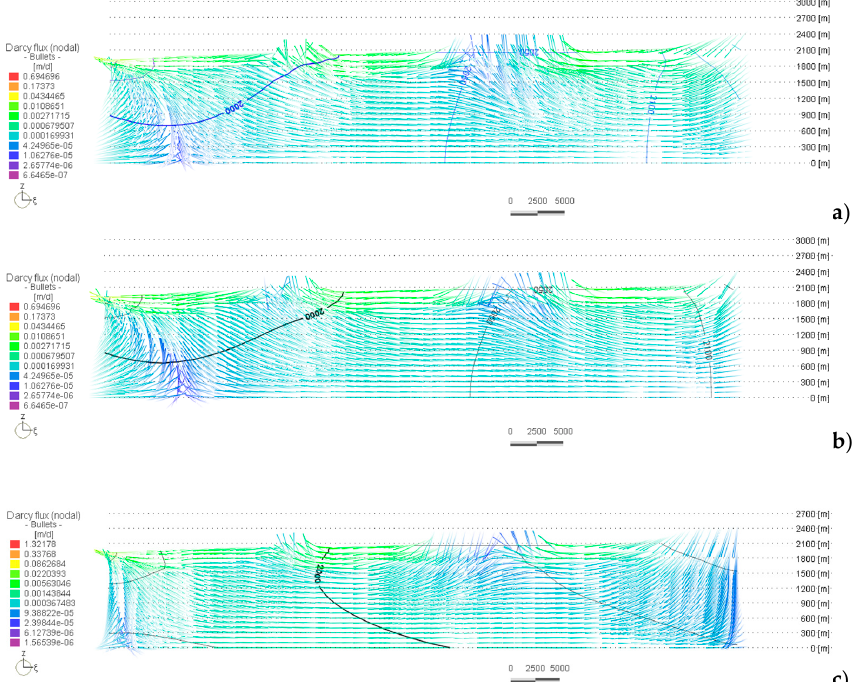
Figure 8. Cross-sections of Laja-E. Distribution of Darcy flux and equipotential lines for: ( a ) scenario for isothermal conditions, scenario I; ( b ) Convective 1, scenario II; and ( c ) Convective 2, scenario III (Table 1). Vertical exaggeration of the scale is 5:1 and 8:1 for the bullets in Darcy flux.